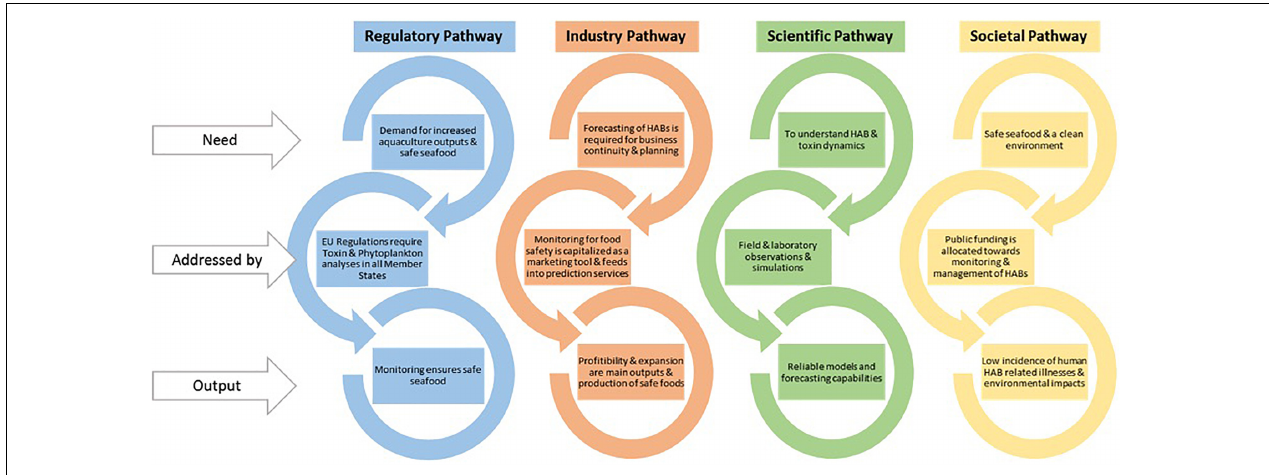
FIGURE 7 | Different sectors have different priorities for HAB and shellfish toxin forecasting in the EU (https://www.coclime.eu/project-overview/co- development-processes).